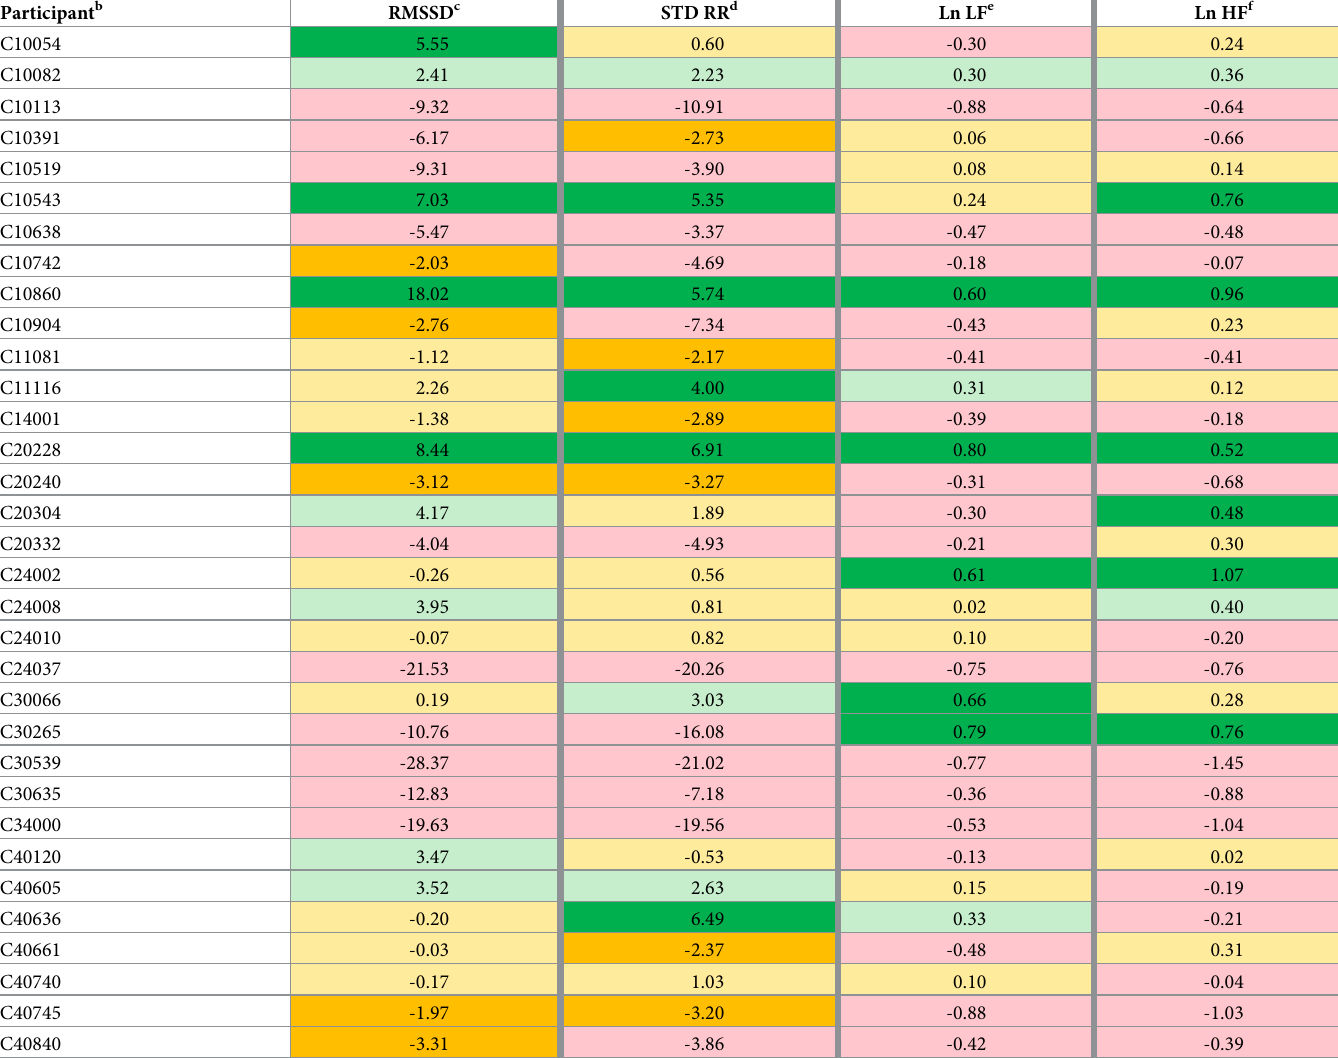
Table 5. Heat-map comparing within-participant differences in mean HRV for non-stressor intervals vs. stressor intervals a . Participant b RMSSD